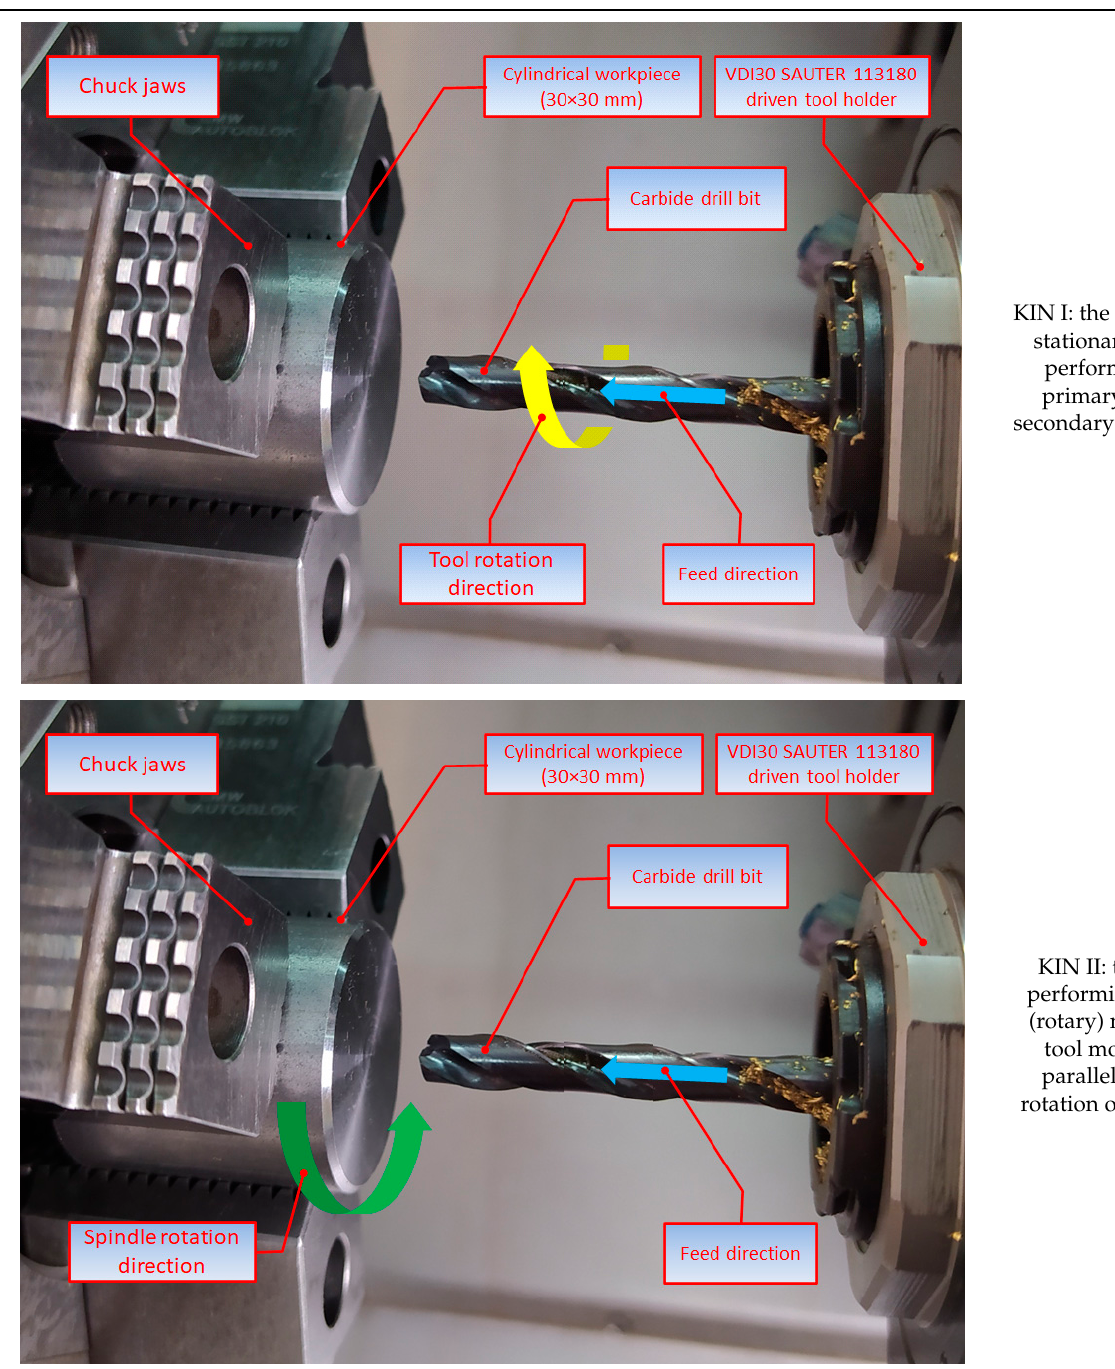
Table 3. Three kinematic systems.